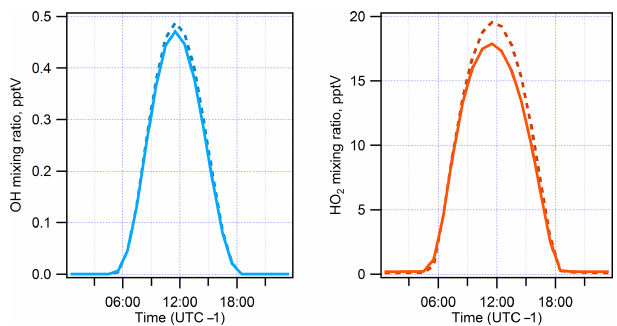
Figure 11. Modelled OH (left) and HO 2 (right) mixing ratios com- paring the base case model where PAN decomposition is the dom- inant source of NO x in the remote MBL (solid lines) with the final model where the dominant source of NO x is particulate nitrate pho- tolysis and HOX + NO 3 chemistry is included (dashed